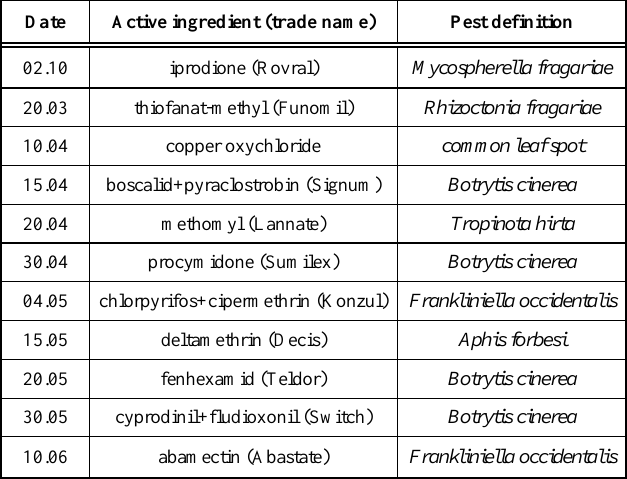
Table 3. Plant protection plan.